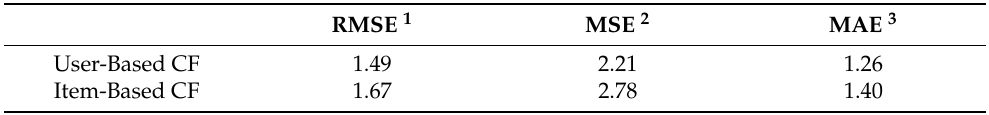
Table 2. Evaluation of prediction accuracy by model, Brazilian Longitudinal Study of Adult Health (ELSA-Brasil), 2008–2010. RMSE 1 MSE 2 MAE 3 User-Based CF 1.49 2.21 1.26